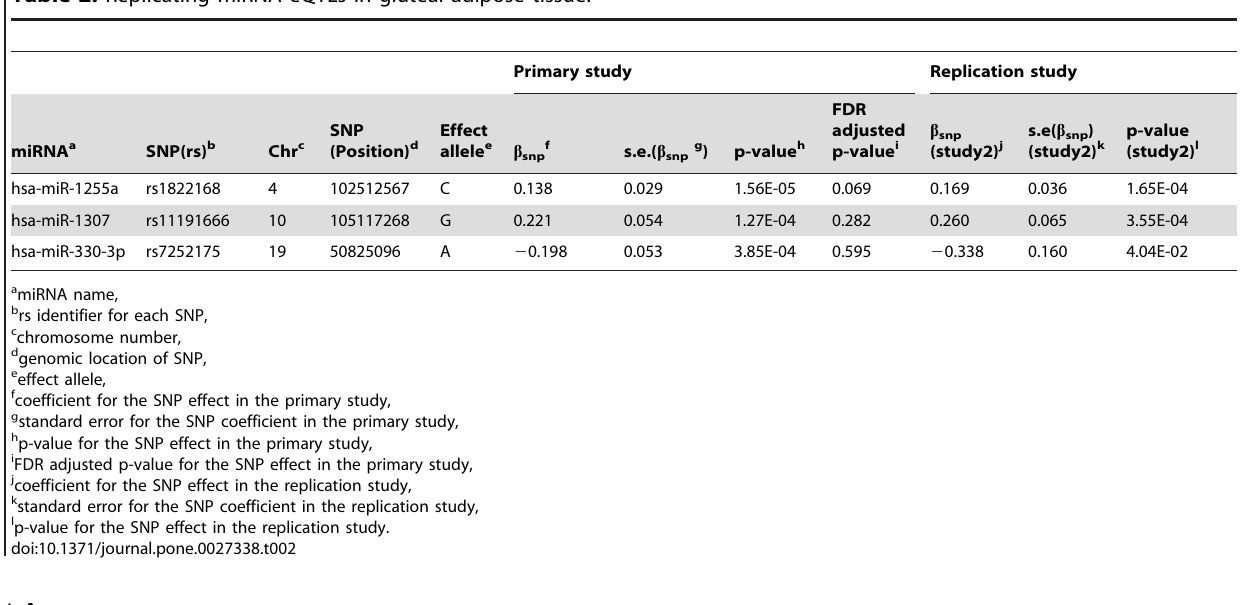
Table 2. Replicating miRNA eQTLs in gluteal adipose tissue.